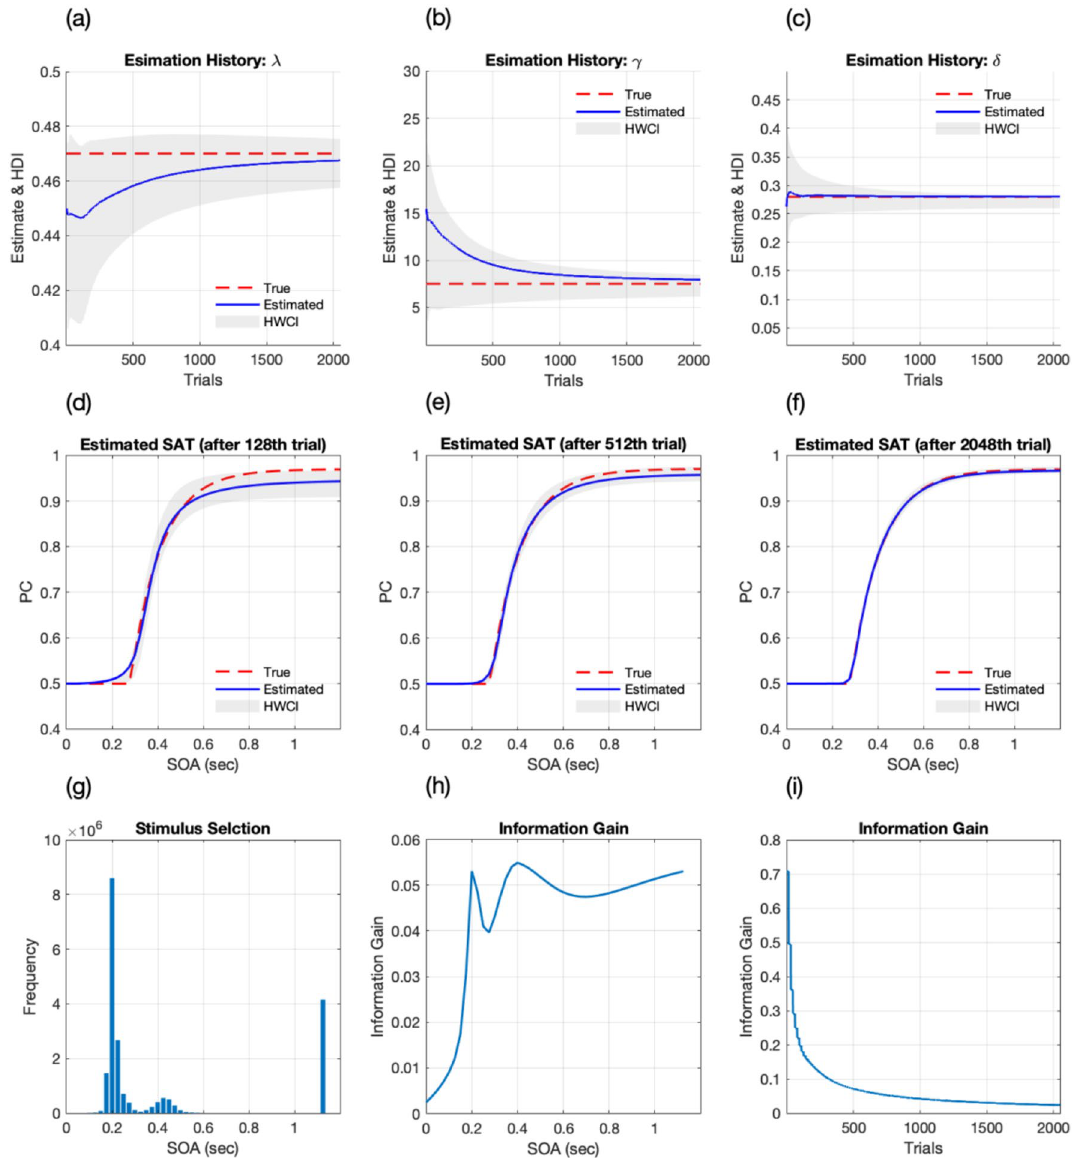
Figure 3. Results of simulations with the Bayesian adaptive estimation (Procedure 4). ( a – c ) Accuracy and precision of λ, γ, δ estimation. The mean of estimated parameters (blue curve) approached the true parameter (red line). HWCI of estimates also quickly decreased as trials were iterated. ( d–f ) Accuracy and precision of the estimated SAT function were obtained with 128, 512, and 2048 trials. With less than 128 trials, the procedure recovered the general shape of the SAT function. Further, it increased both accuracy and precision ( g ) stimulus selection occurred intensively in three SOA ranges: short (0.2–0.3 s), mid (0.35–0.45 s), and long (1.2 s) ( h ) information gain over SOA was maximum at the three SOA ranges where the stimulus was frequently selected. ( i ) Information gain was much higher in earlier trials than later 512 trials, and 1.164 after 2048 trials for γ; started at 0.135 in the first trial, and decreased to 0.042 after 128 trials, 0.022 after 512 trials and 0.011 after 2048 trials for δ. Figure 3d–f shows the accuracy and precision of the estimated SAT functions obtained with 128, 512, and 2048 trials. The true SAT functions are plotted as red curves, and the estimated functions are shown as blue curves. Shaded areas represent the 68.2% HWCI of the estimated functions over simulations. With increasing trial numbers, the procedure improved accuracy (decreasing discrepancy between blue and red curves) and precision (reducing shaded area) of the estimated SAT functions. It took less than 100 trials to recover the SAT function’s general shape (average absolute bias = 0.020) and decreased to below 0.019 after 128 trials, 0.011 after 512 trials, and 0.005 after 2048 trials. The average 68.2% HWCI became less than 0.021 after 128 trials, and decreased to below 0.012 after 512 trials and 0.006 after 2048 trials. The results indicate that Procedure 3 can rapidly estimate the true SAT function with only a small number of trials compared to the conventional SAT procedure.